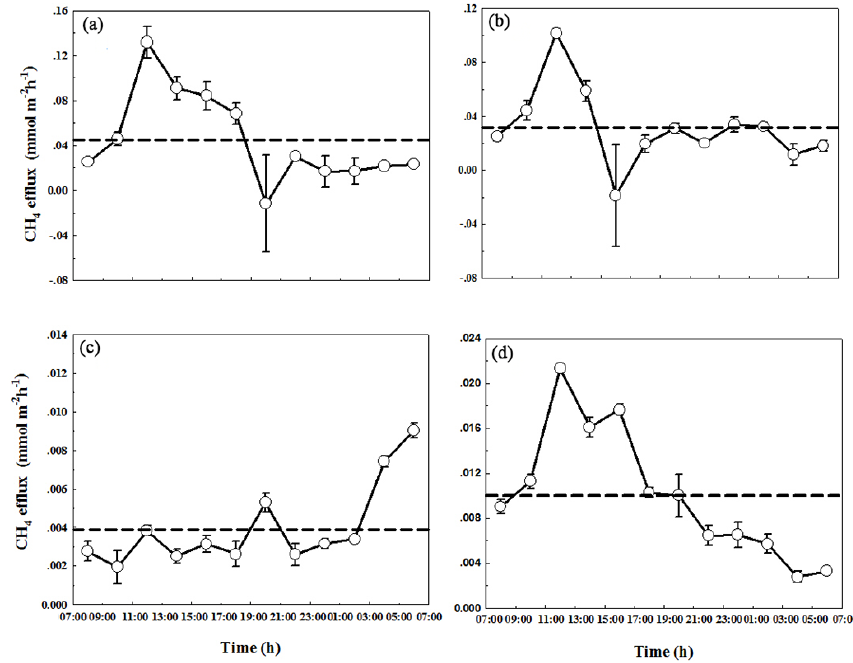
Figure 4. Diel variations of CH 4 effluxes in Poyang Hu. Different panels present the diel variations of the CH 4 effluxes in 24– 25 July 2011 (a) , 5–6 September 2012 (b) , 13–14 January 2013 (c) , and 14–15 January 2015 (d) . White circles describe the diel variations of the CH 4 effluxes. Horizontal short dashed lines mean the average value of the diel CH 4